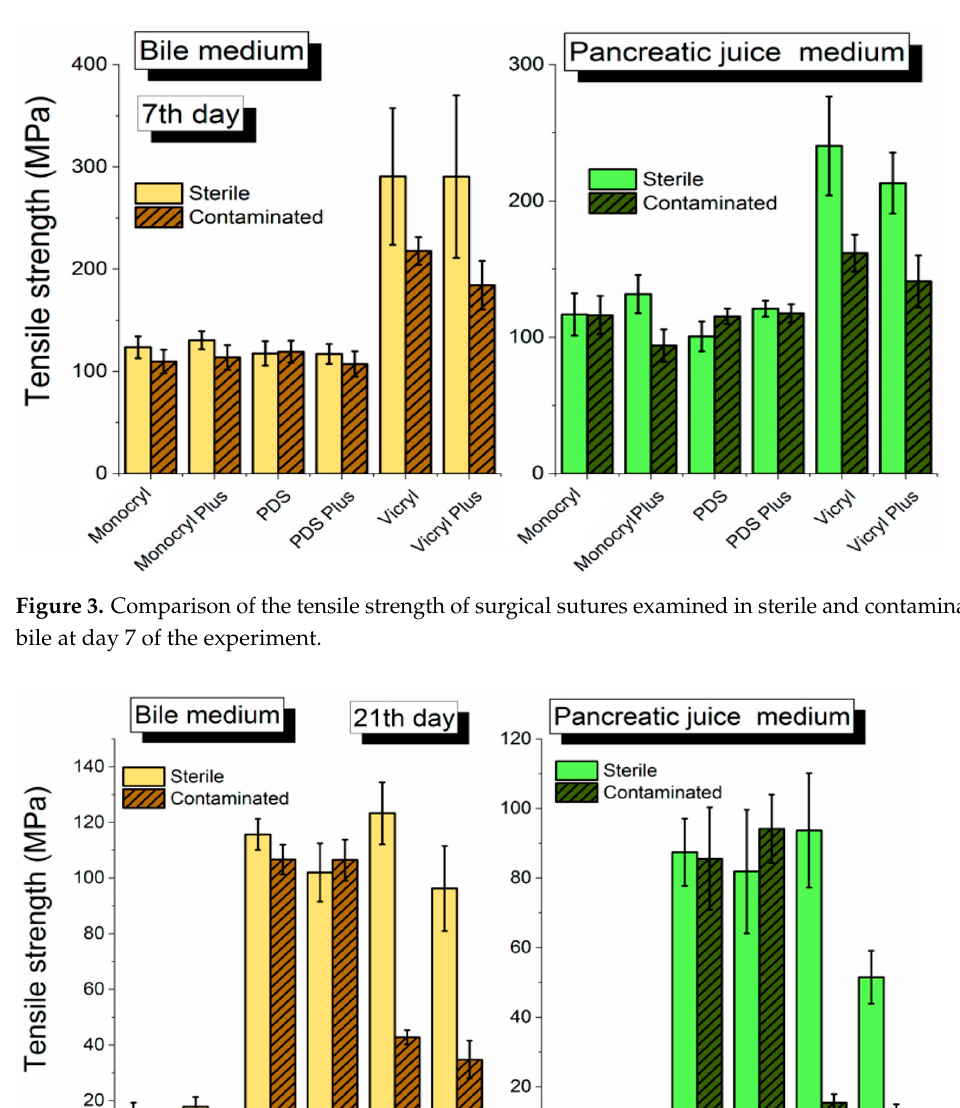
Figure 4. Comparison of the tensile strength of surgical sutures in bile and pancreatic juice (sterile and contaminated material) on day 21 of the experiment.